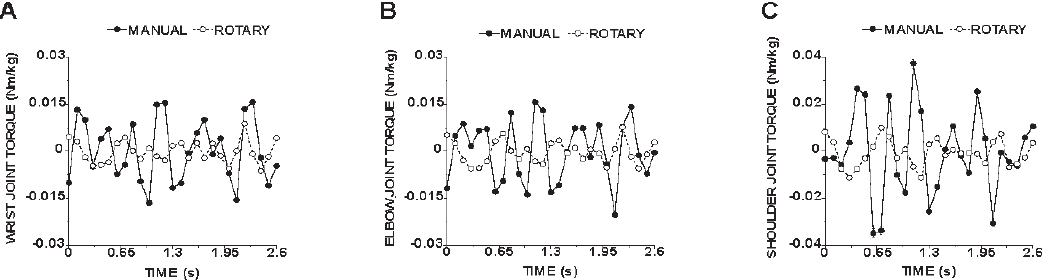
Figure 3- Comparison between the manual and rotary methods according to the average and standard error across all subjects of the joint torque (Nm/kg) for the wrist (A), elbow (B) and shoulder (C), during all intervals calculated (each 100 ms) for each instrumental